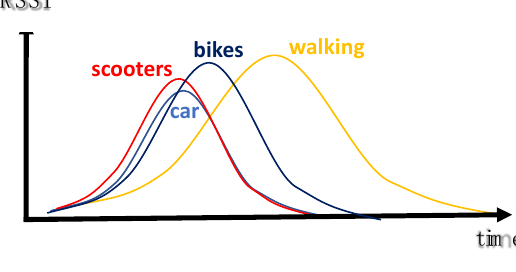
Figure 4. The variation of RSSI in TMP.